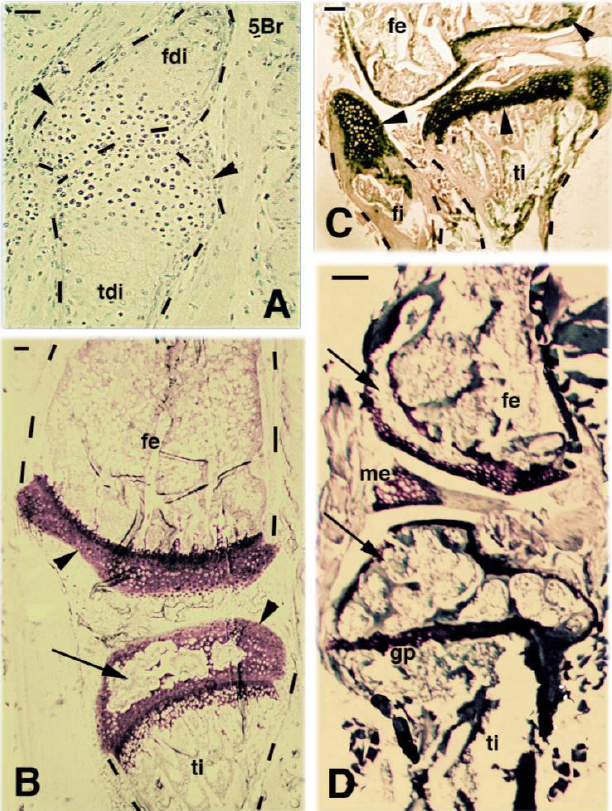
Figure 1. Microscopic images of developing ( A , Light toluidine blue stain.), juvenile ( B , toluidine blue stain), and adult ( C , D ), Methylene blue—Eosin stain) knee. ( A ) immunostaining for 5-bromo-deoxy-uridine (5BrdU) (5Br, 2 days post-injection) showing labeled cells (dark spots) located mainly in the epiphyses (arrowheads) of developing femur and tibia at stage 35 in Anolis lineatopus . Bar, 20 μm; ( B ) juvenile knee showing the still developed articular cartilages (arrowheads) in Podarcis muralis . The initial formation of a secondary ossification center (arrow) is seen in the tibia. Bar, 20 μm; ( C ) reduction of the articular cartilage in this part of the femur while a larger cartilage is seen in the tibia and the narrow fibula epiphysis (arrowheads) in P. muralis . Bar, 50 μm; ( D ) most of the tibia and femur epiphyses is occupied by ossification centers (arrows) and little cartilage remains in adults of P. muralis. Bar, 100 μm. Legends: fdi, femur diaphysis (differentiating); fe, femur; fi, fibula; me, meniscus; gp, growth plate (metaphyseal plate); tdi, tibia diaphysis (forming); ti, tibia; The dashes outline the bone shape.